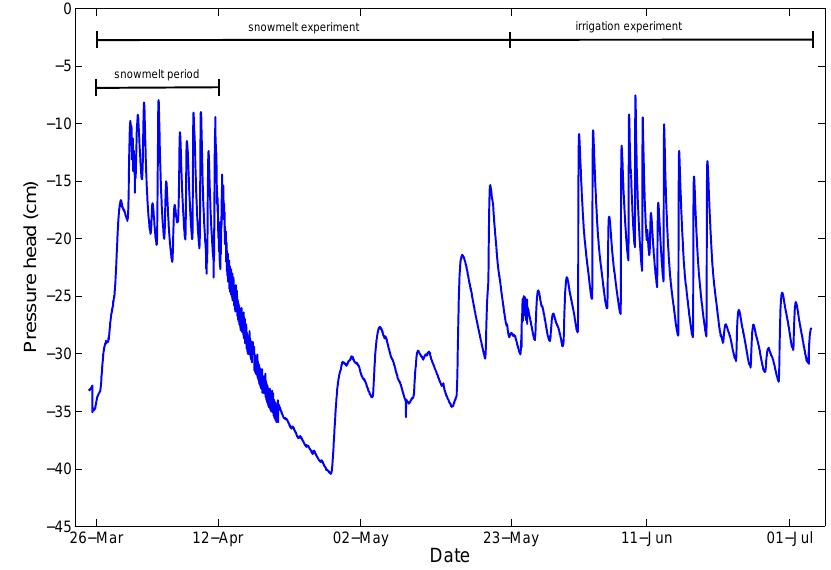
Fig.6. Averagepressurehead( cm )at51 cm depthduringthesnowmeltandtheirrigationexperiment(in2010). Fig. 6. Average pressure head (cm) at 51cm depth during the snowmelt and the irrigation experiment (in